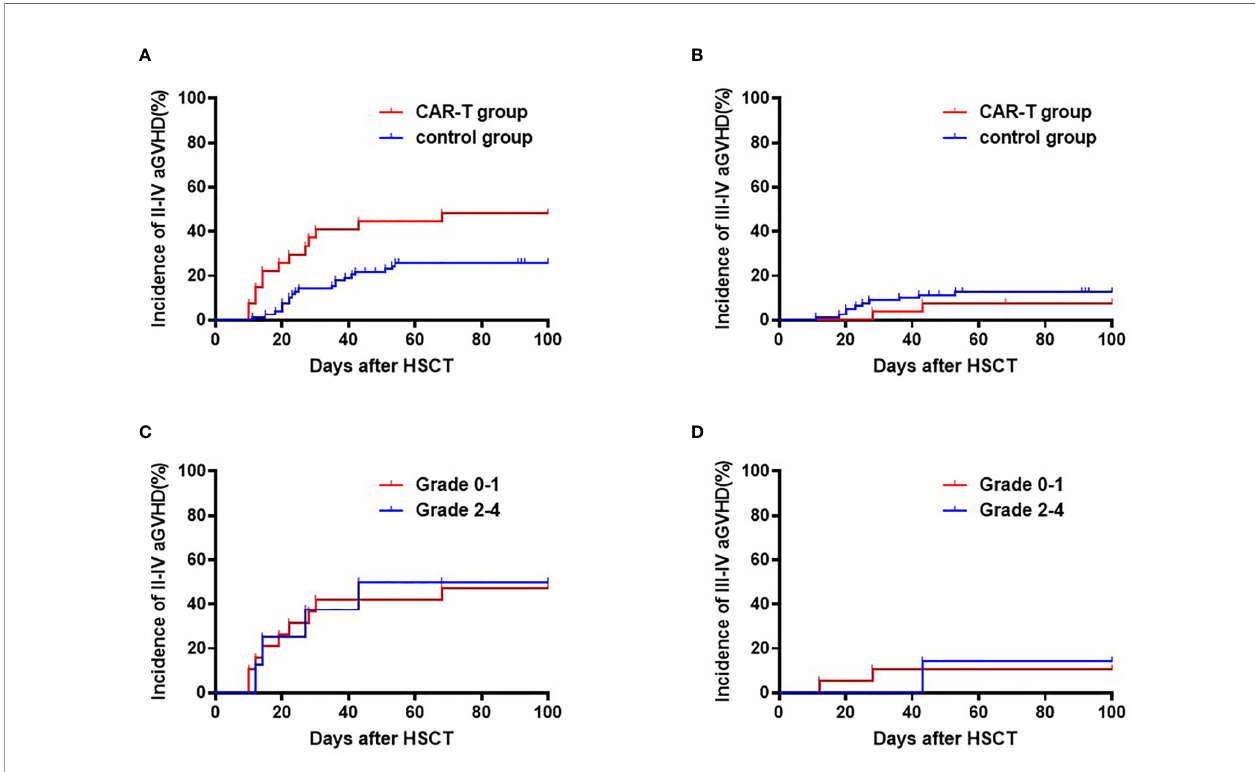
FIGURE 2 | Cumulative incidences of Grade II-IV and Grade III-IV acute GVHD. (A) Cumulative incidences of Grade II-IV acute GVHD: CAR-T group: 48.1% (95% CI:46.1, 50.1%) vs. chemotherapy group: 25.6% (95% CI: 25.2, 26.0%); p=0.016. (B) Cumulative incidences of Grade III-IV acute GVHD: CAR T-cell group: 11.1% (95% CI: 10.3, 11.9%) vs. chemotherapy group: 11.5% (95% CI: 11.3, 11.7%); p=0.945. (C) Cumulative incidences of Grade II-IV acute GVHD: CRS Grade 0-I 47.4% (95% CI: 44.7, 50.1%) vs. CRS Grade II-IV: 50.0% (95% CI:42.6, 57.4%); p=0.95. (D) Cumulative incidences of Grade III-IV aGVHD: CRS Grade 0-I: 10.5% (95% CI: 9.5, 11.5%) vs. CRS Grade II-IV: 12.5% (95% CI: 9.4, 15.6%);